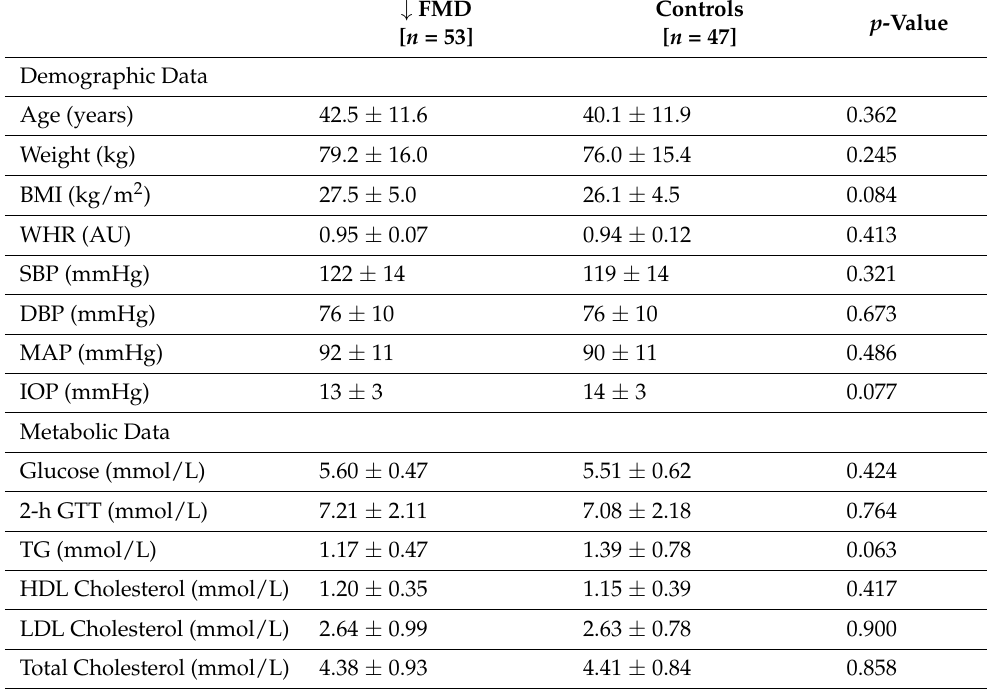
Table 2. Baseline Characteristics of the Study